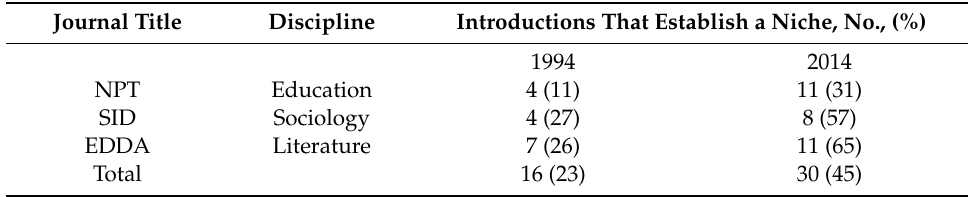
Table 2. Number and percentages of introductions that establish a